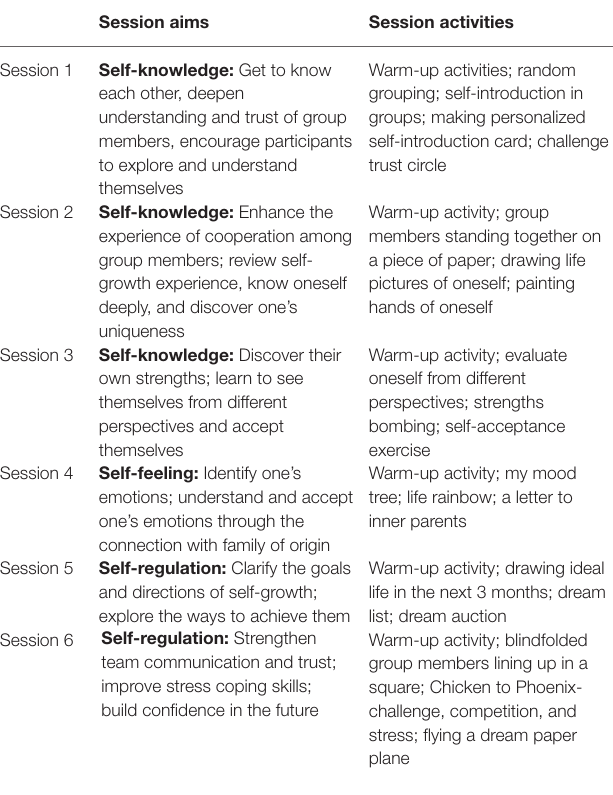
TABLE 3 | Description of the self-focused group